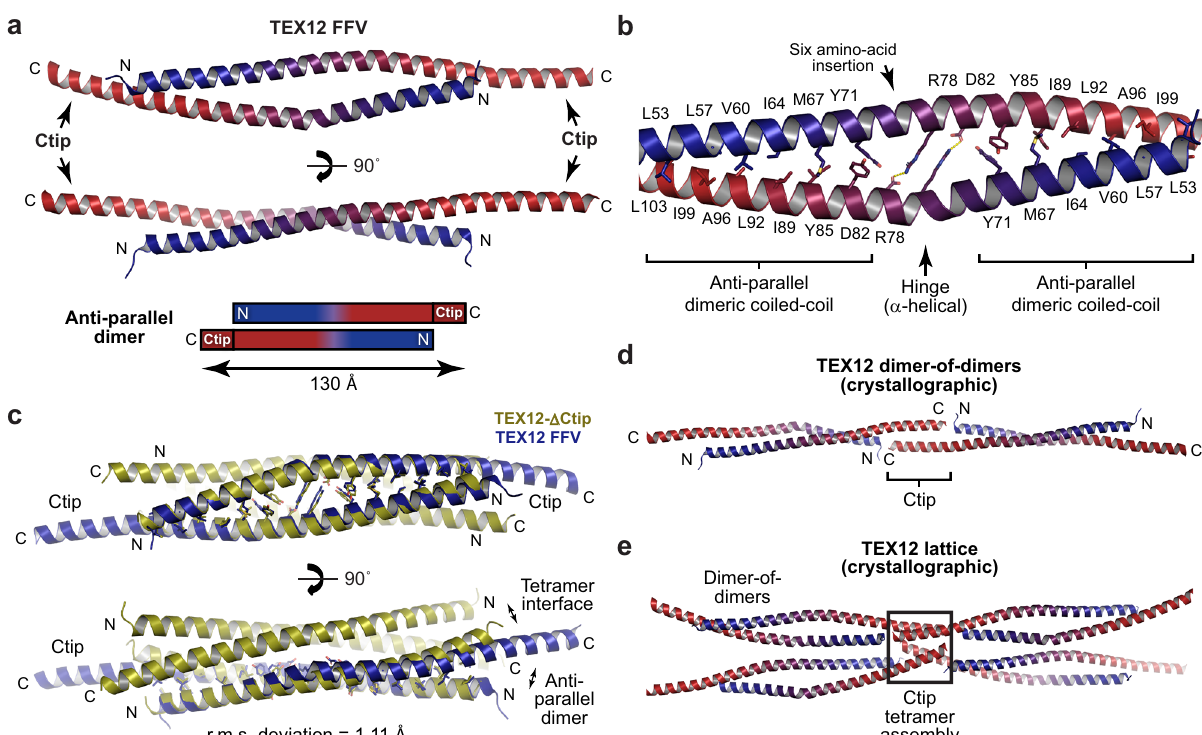
Fig. 4 Crystal structure of TEX12 FFV in a dimeric conformation. a Crystal structure of a TEX12 FFV dimer. The two TEX12 chains (coloured blue to red in an N- to C-terminal direction) are arranged in an anti-parallel con fi guration such that their Ctip sequences project from either side of the core dimer, formed of amino-acids 49 – 113, to form a 130 Å molecule. b The dimeric core is formed of two anti-parallel coiled-coils with a midline six amino-acid insertion, forming a central hinge of R78-D82 salt bridges that act as struts to locally separate the interacting chains. c Superposition of the TEX12 FFV dimer structure (blue) and a constituent dimer of the TEX12 Δ Ctip structure (yellow), demonstrating their shared hinge and dimer interface (r.m.s. deviation of 1.11). d , e The TEX12 FFV crystal lattice includes ( d ) end-on dimer-of-dimers assembly through formation of anti-parallel coiled-coils between Ctip sequences, which ( e ) interact with the Ctip ends of two additional molecules within anti-parallel Ctip tetrameric